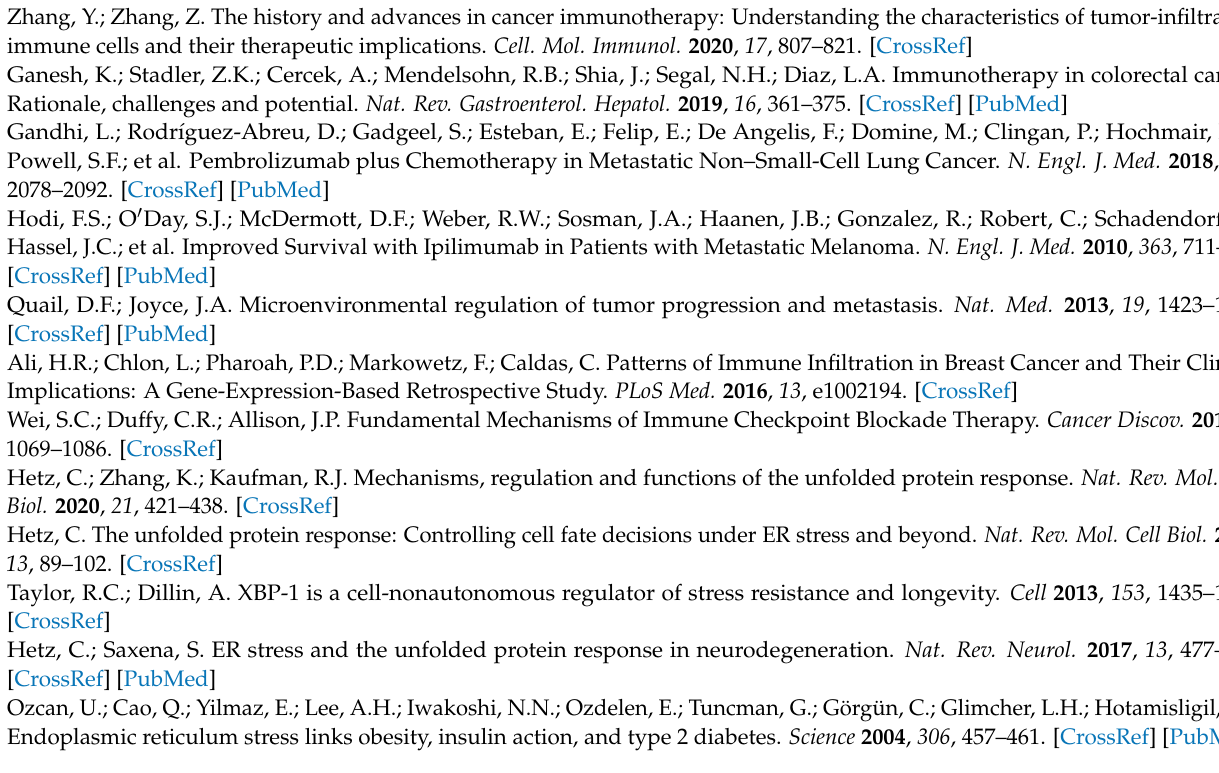
tary Table S5. Forward and reverse primer sequences; Supplementary Table S6. Clinical characteristics of 884 CRC patients from GSE17536, GSE38832, and GSE39582 datasets; Supplementary Table S7. ER stress-related ERcluster and GeneCluster in GEO datasets; Supplementary Table S8. Functional analysis of DEGs between ERcluster A and ERcluster